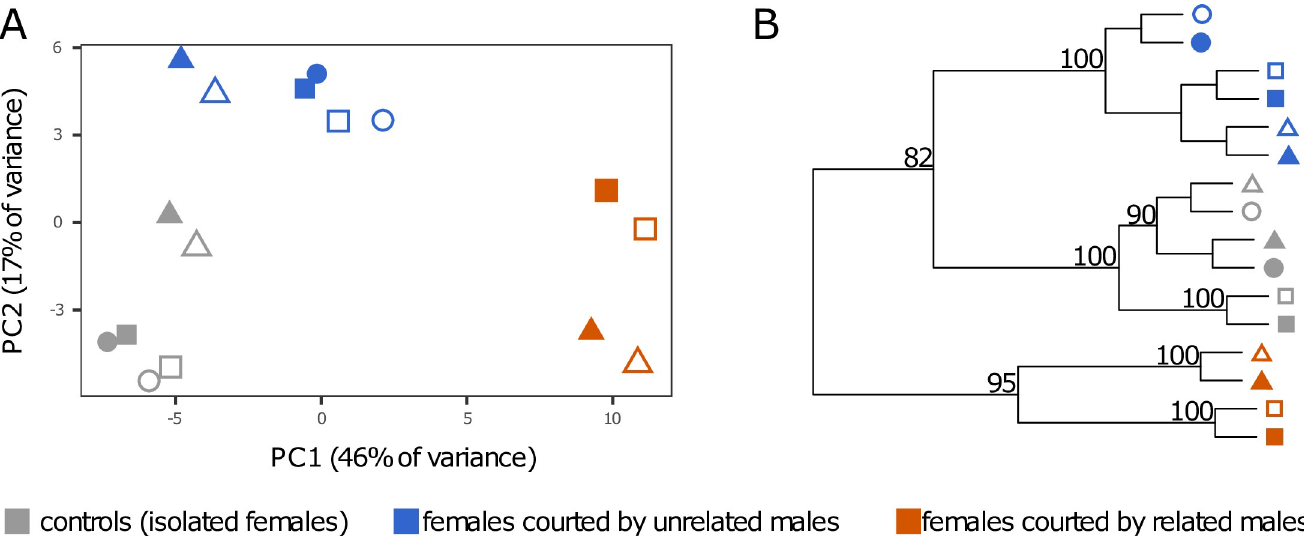
Fig 1. Multivariate analysis of the 16 RNA-seq libraries based on the gene expression profiles of the 500 genes with the highest variance across samples. The samples are clustered by the experimental conditions that females were exposed to. Experimental conditions are represented by the three different colours (grey: control; orange: females courted by related males; blue: courted by unrelated males), shapes indicate the three biological replicates, and the filling of the shape shows the 2 technical replicates. ( A ) Two-dimensional principal component analysis (PCA) plot. ( B ) Hierarchical clustering dendrogram based on sample-to-sample distances. Statistical support is indicated by an approximately unbiased P -value with one million multiscale bootstrap resamplings (all bootstrap values were > 50%, those < 80% were not shown for clarity).